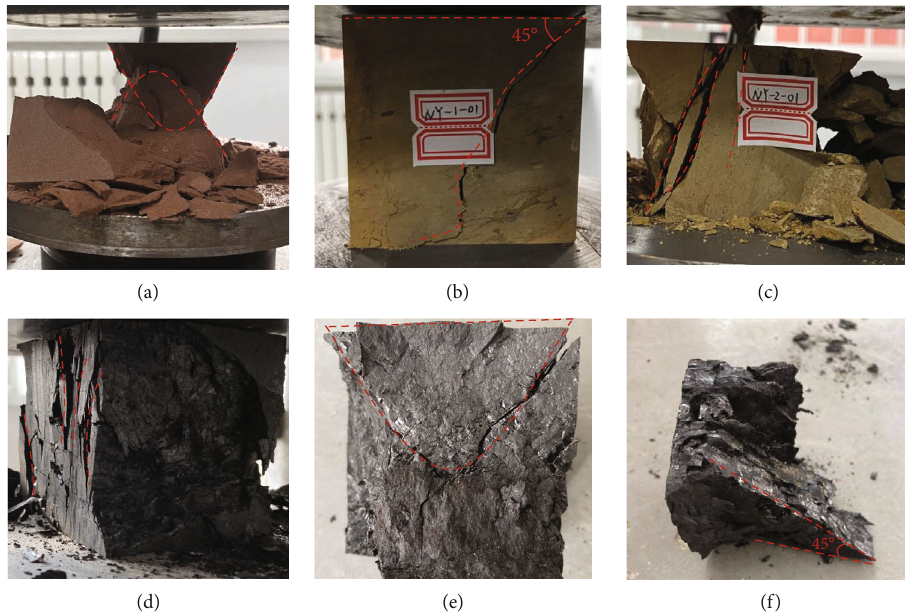
Figure 7: Typical fracture patterns for di ff erent lithological specimens. (a) Sandstone (cone damage). (b) Mudstone (45 ° shear damage). (c) Mudstone (crack break). (d) Coal (split break). (e) Coal (tapered damage). (f) Coal (45 ° shear damage).